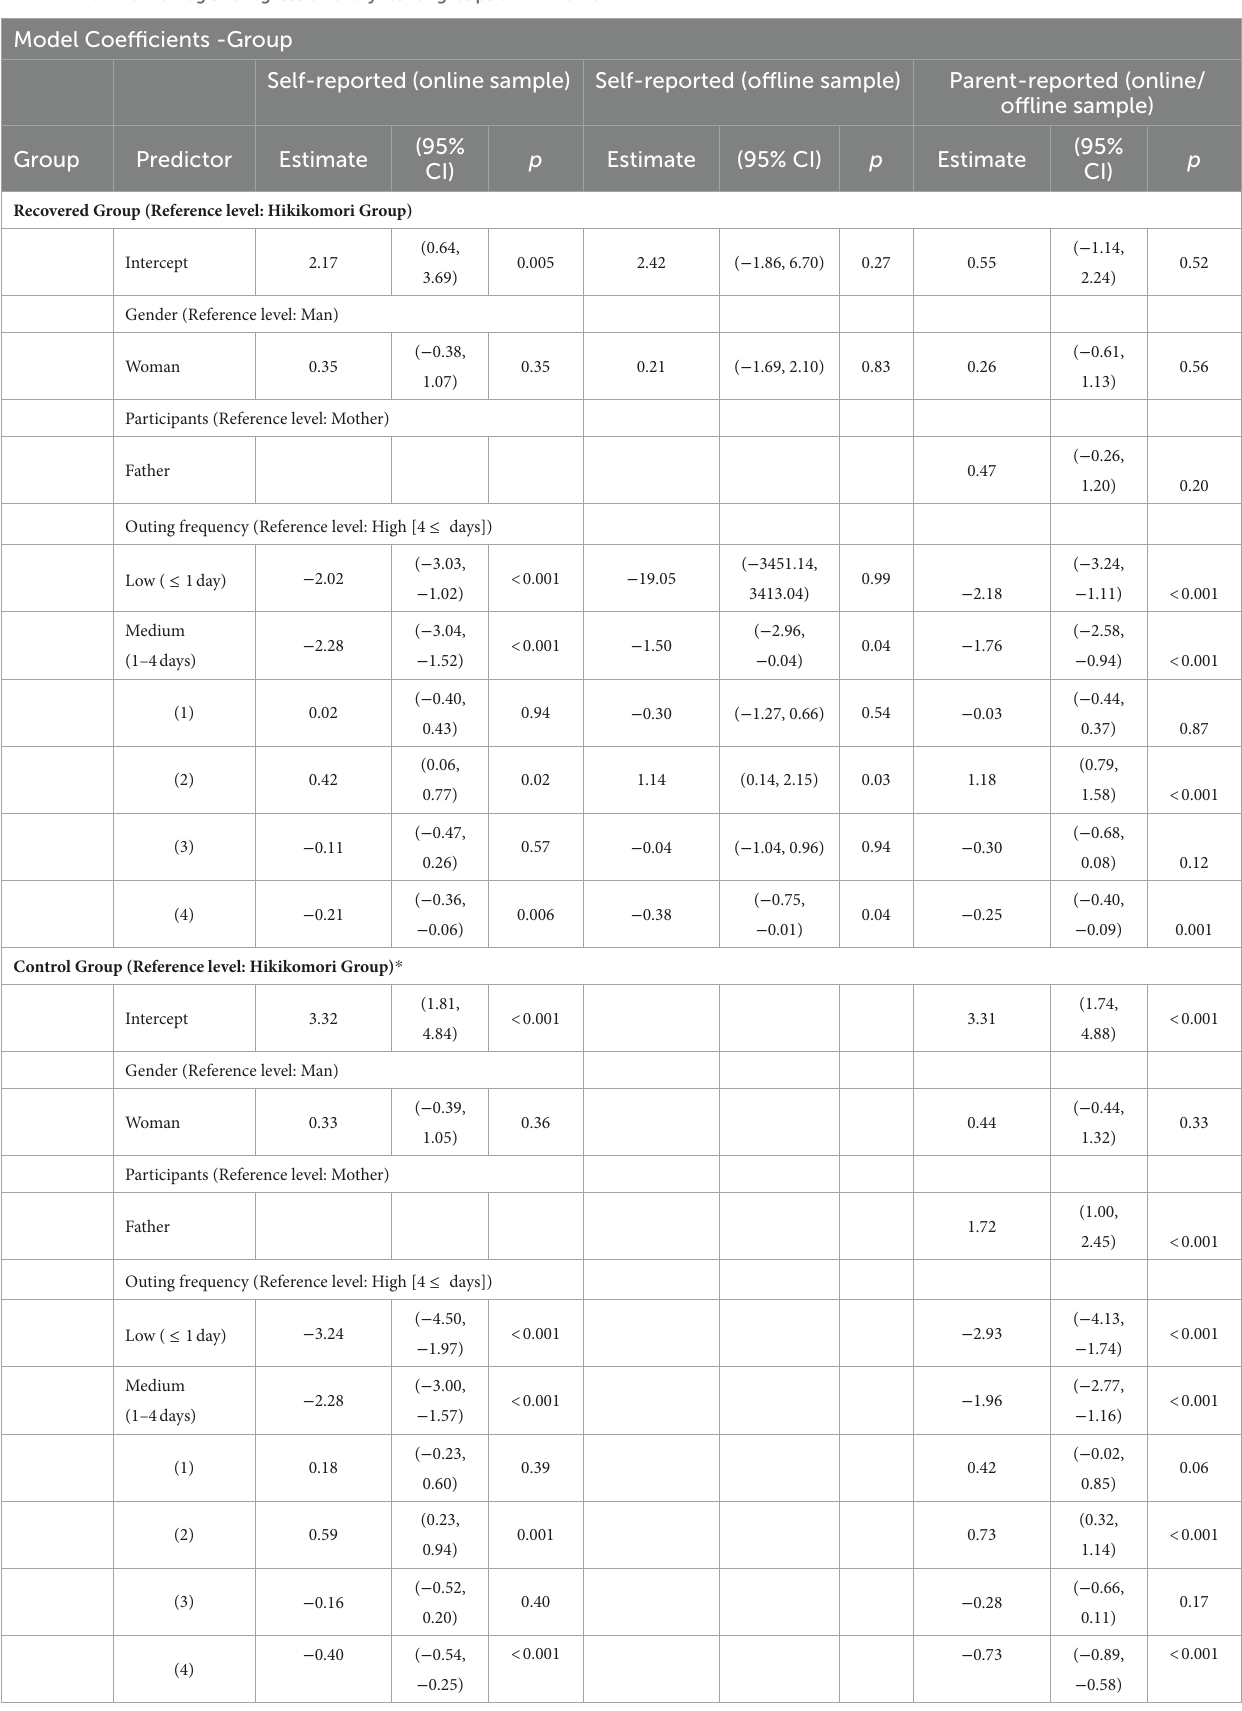
TABLE 4 Multinomial logistic regression analyzes for groups on hikikomori. Model Coefficients -Group Self-reported (online sample) Self-reported (offline sample) Parent-reported (online/